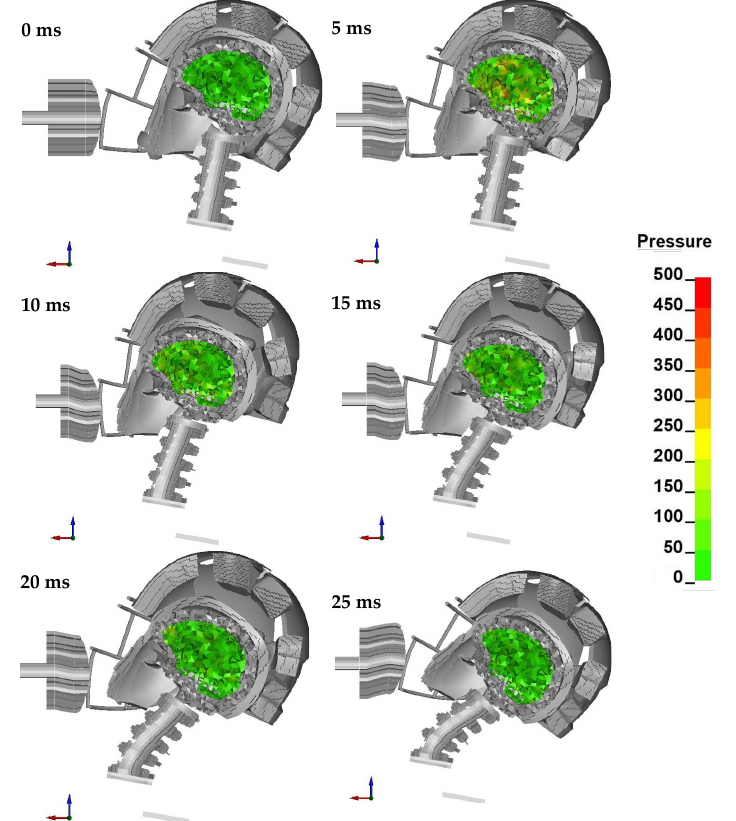
Figure A6. Head kinematics during the numerical test, configuration B, with the cross-section in the median plane and showing the hydrostatic pressure (kPa) in the brain.